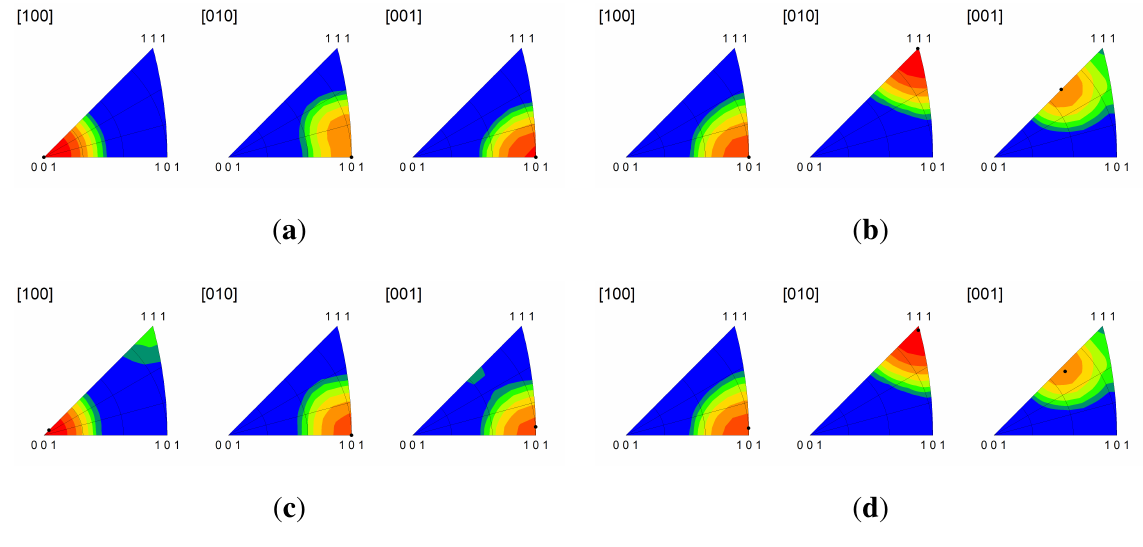
Figure 5. Combined inverse pole figures at 50% reduction from the multicrystal simulations for the ( a ) copper phase in the Goss-I interface; ( b ) niobium phase in the Goss-I interface; ( c ) copper phase in the Z-I interface; and ( d ) niobium phase in the Z-I interface. The final orientations obtained from the periodic bicrystal simulations are indicated by the filled black circles. RD [100] / TD [010] / ND [001]